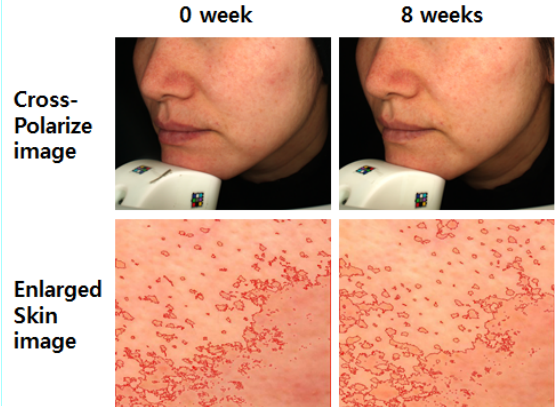
Figure 6. Skin color images following 8 consecutive weeks’ use of corn silk extract 1.5% aqueous